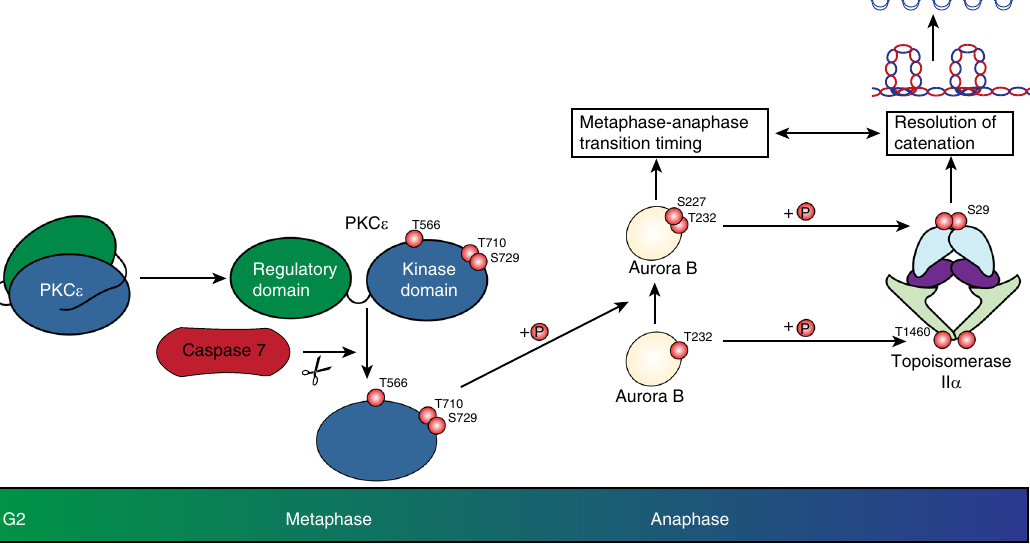
Fig. 6 Working model of non-canonical PKC ε signalling in response to excess metaphase catenation. In mitosis, Aurora B switches substrate speci fi city in response to phosphorylation of S227 in the activation loop by a cell cycle-processed active fragment of PKC ε . Here, we show that this switch